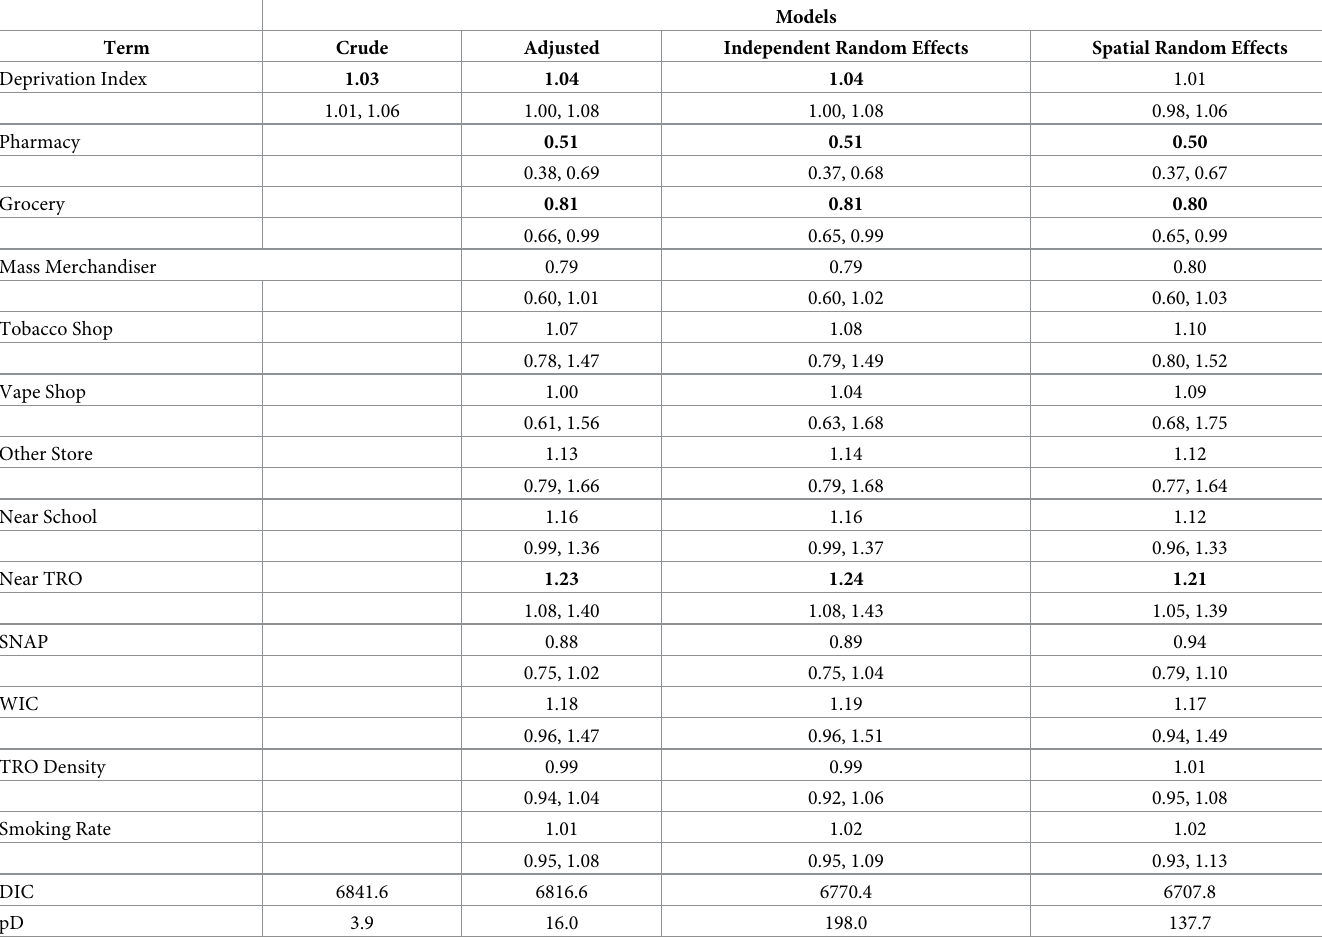
Table 3. Odds ratio and 95% confidence intervals from Bayesian index regression models for the probability of a TRO sales violation.